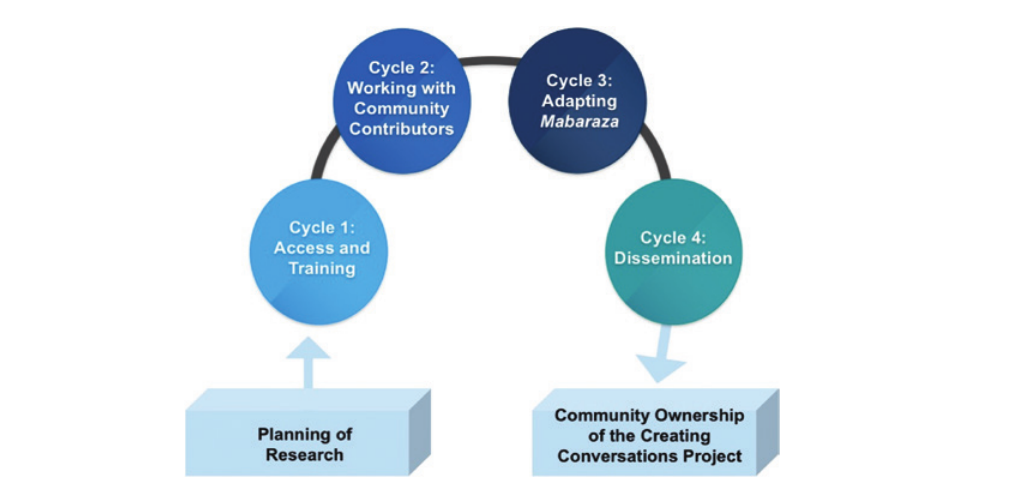
Figure 1: Research design (source: